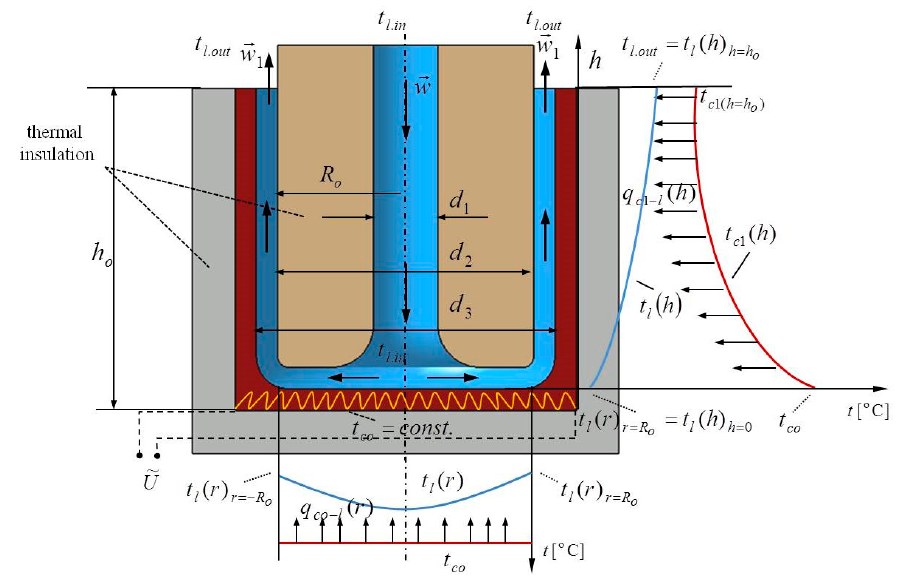
Figure 1. The central impact liquid on the bottom of the cylindrical